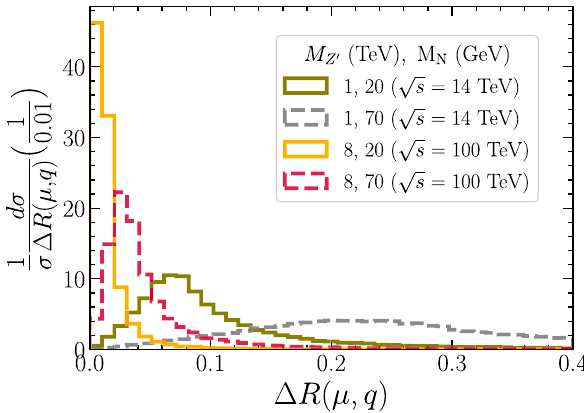
Fig. 8 (cid:2) R separation between the μ and closest q at the partonic level